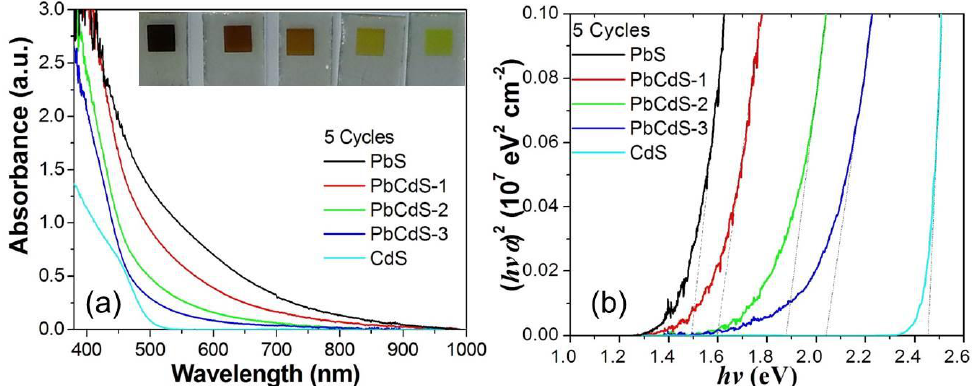
Figure 2. Absorption spectra ( a ) and Tauc plots ( b ) of five-SILAR-cycle PbS, PbCdS-1, -2, -3, and CdS-sensitized TiO 2 films. The bare TiO 2 film was used as blank in the absorption measurement. Inset images of ( a ) show the PbS, PbCdS-1, -2, -3, and CdS electrodes in turn from left to right. The doted tangent lines of the linear region of plots in ( b ) show the linear fit for the bandgap energy of QDs.